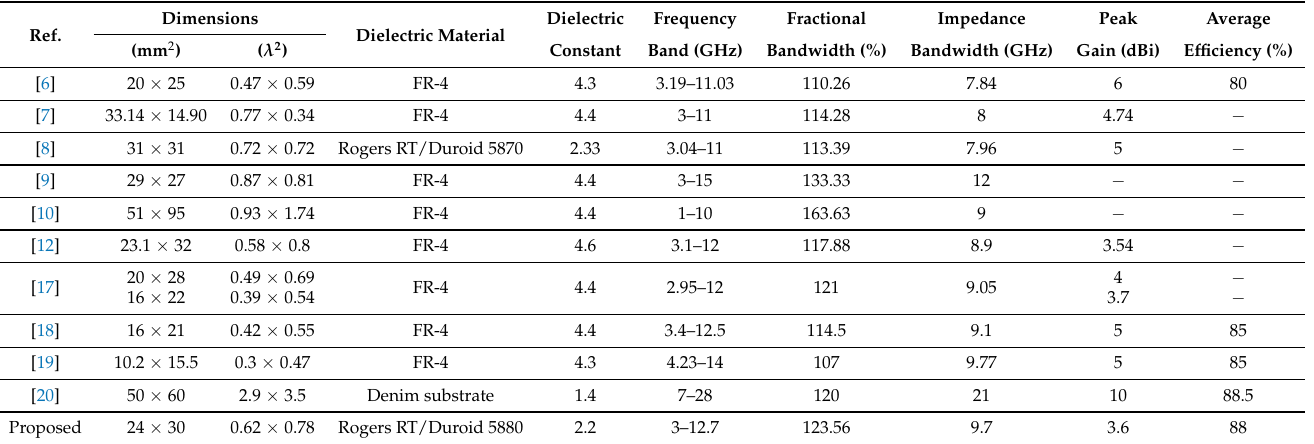
Table 1. Comparative analysis among proposed and previously presented planar monopole antennas for microwave imaging applications.